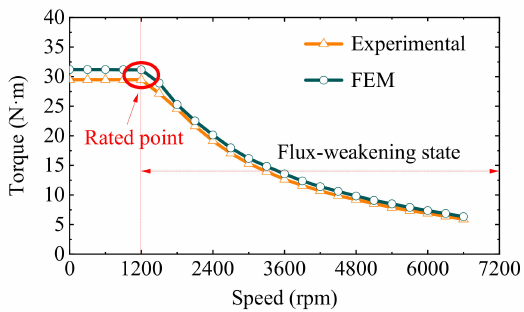
Figure 16. The experimental platform.